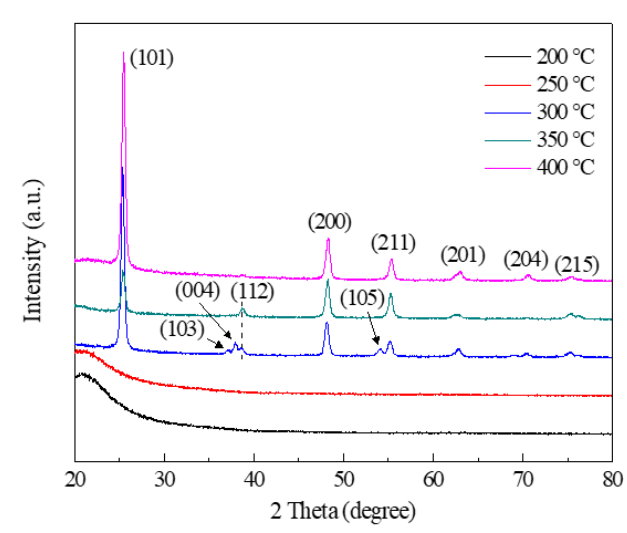
Figure 2. Grazing incidence X-ray diffraction (GIXRD) patterns of TiO 2 films deposited under different temperatures using the mist CVD method.